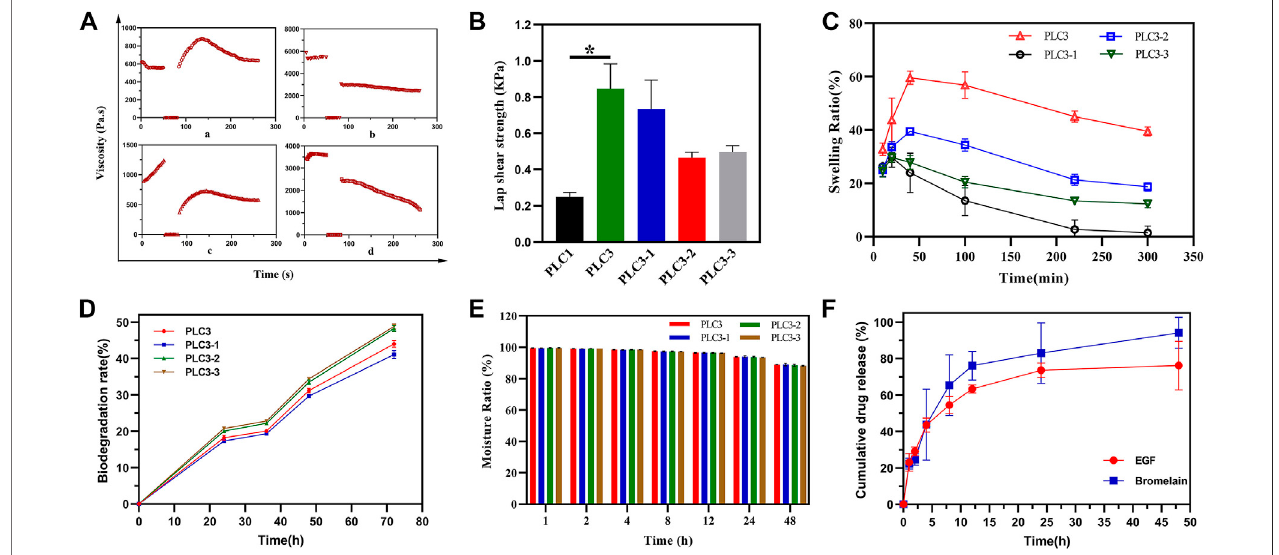
FIGURE 3 | (A) Thixotropy test of a) PLC3, b) PLC3-1, c) PLC3-2, and d) PLC3-3. (B) The lap shear strength for hydrogels adhering to gelatin fi lm. (C) Swelling tests, (D) biodegradation evaluation, and (E) moisture retention assay of PLC3, PLC3-1, PLC3-2 and PLC3-3. (F) Drugs release curve in 48 h. With the data shown as means ± SD ( n (cid:1) 3, * p <